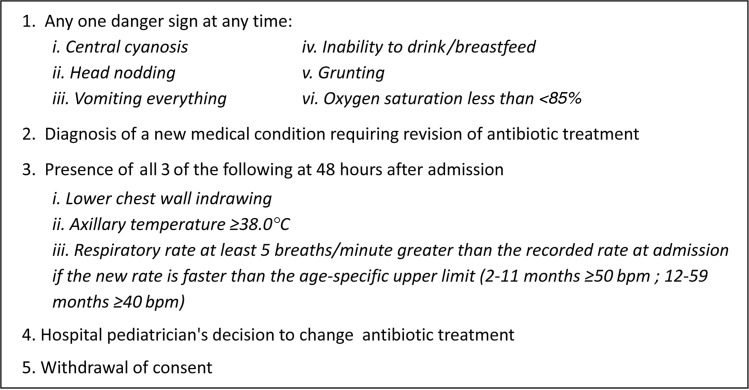
Criteria for treatment failure. Abbreviation: bpm, breaths per minute.